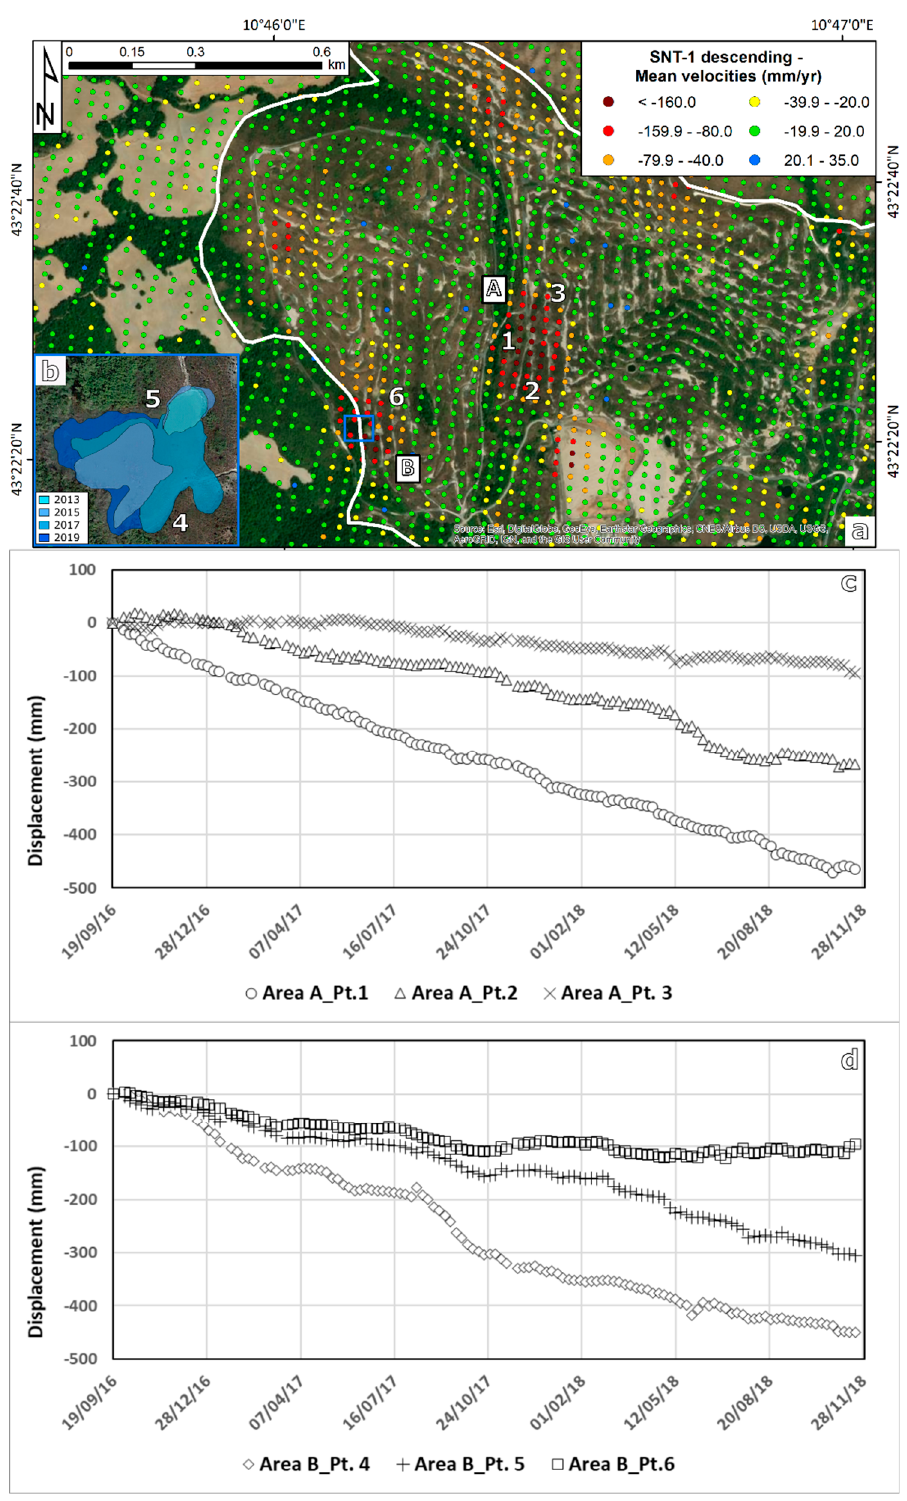
Figure 6. ( a ) Deformation map for the high deformation area of Buriano-Casanova. A and B are the two subsidence bowls with the highest deformation rates: the first with no signs of sinkhole development, the second with a well-developed sinkhole expanding over time (see inset b, whose location is indicated by the blue square). Numbers 1 to 6 indicate areas where the time series of insets ( c ) and ( d ) have been extracted. The background image of inset ( a ) is an ESRI World Image. Inset ( b ) image is a Google Earth imagery.